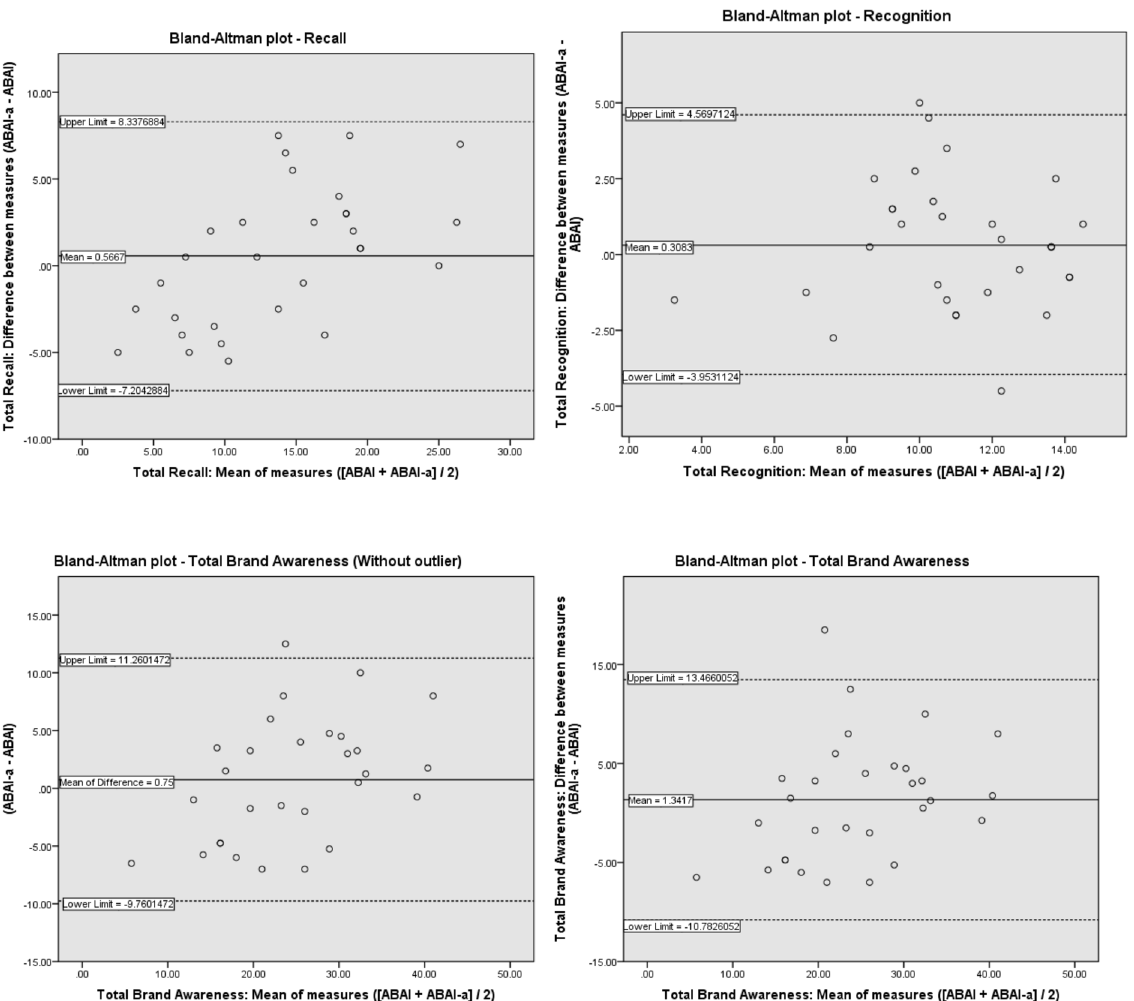
Fig 2. Bland-Altman plots assessing the validity of the ABAI-a v. the ABAI for recall, recognition and total brand awareness (with and without one outlier) among children (n 30) aged 7 – 11 yrs, Illawarra, Australia, July-Aug 2014. Plots show the mean difference (centre horizontal lines), and the 95% limits of agreement (dotted lines) for: (a) brand recall, (b) brand recognition, (c) total brand awareness (with outlier), (d) total brand awareness (outlier removed).